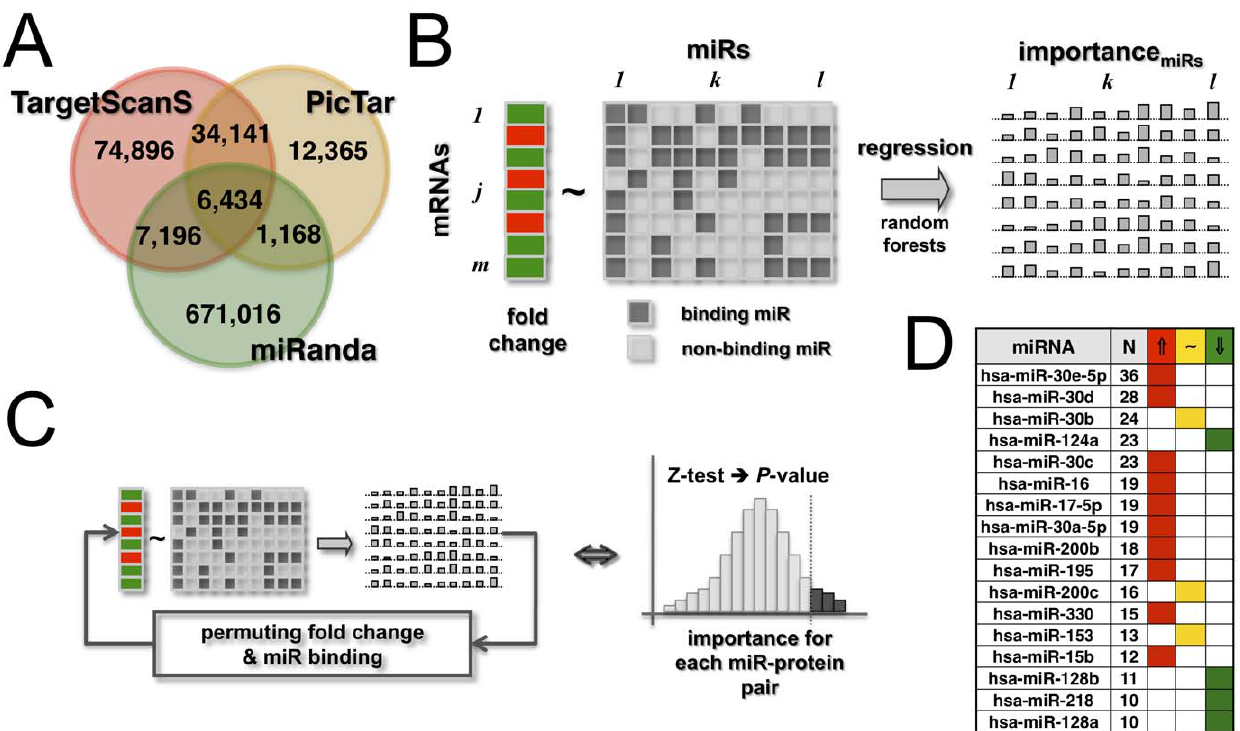
Figure 1. Determination of significantly associated miRs. In ( A ) we show the overlaps between sets of different sources of physical miR-mRNA interactions. Only accounting for potential interactions that at least were predicted by two methods we assembled 48,939 interactions. In ( B ) we assumed that the expression fold change of mRNAs is a function of the miRs that specifically bind the underlying mRNAs. As such, we represented the presence/absence of binding miRs as a binary (1/0) matrix, where each of the units is 1 if the corresponding miR can physically interact with the mRNA and 0 otherwise. mRNAs are represented as a vector of their corresponding expression fold changes. Utilizing random forest regression we determined miRs that are significantly associated with the fold change of mRNAs. Specifically, each pair of mRNA and miR is represented by a local importance measure reflecting the drop/gain of regression accuracy of a mRNAs fold change if the underlying miR is excluded. ( C ) Determining their statistical significance by a Z-test, we iteratively permuted the vector of fold changes and the binding matrix of miRs and calculated local importance values after each permutation step. ( D ) Utilizing a set of human genes that are involved human signaling pathways, we determined 128 miRs that are significantly associated to the fold change of mRNAs, comparing 27 GBM samples to non-tumor control cases (P , 0.05). In the table we show miRs that have been found to be significantly associated to N $ 10 mRNAs. We observed that such miRs are predominantly over-expressed( X , expression fold change FC . 1), while a minority of miRs are under-expressed ( Y , FC ,2 1) or unchanged ( , , 2 1 # FC # 1) in GBMs.